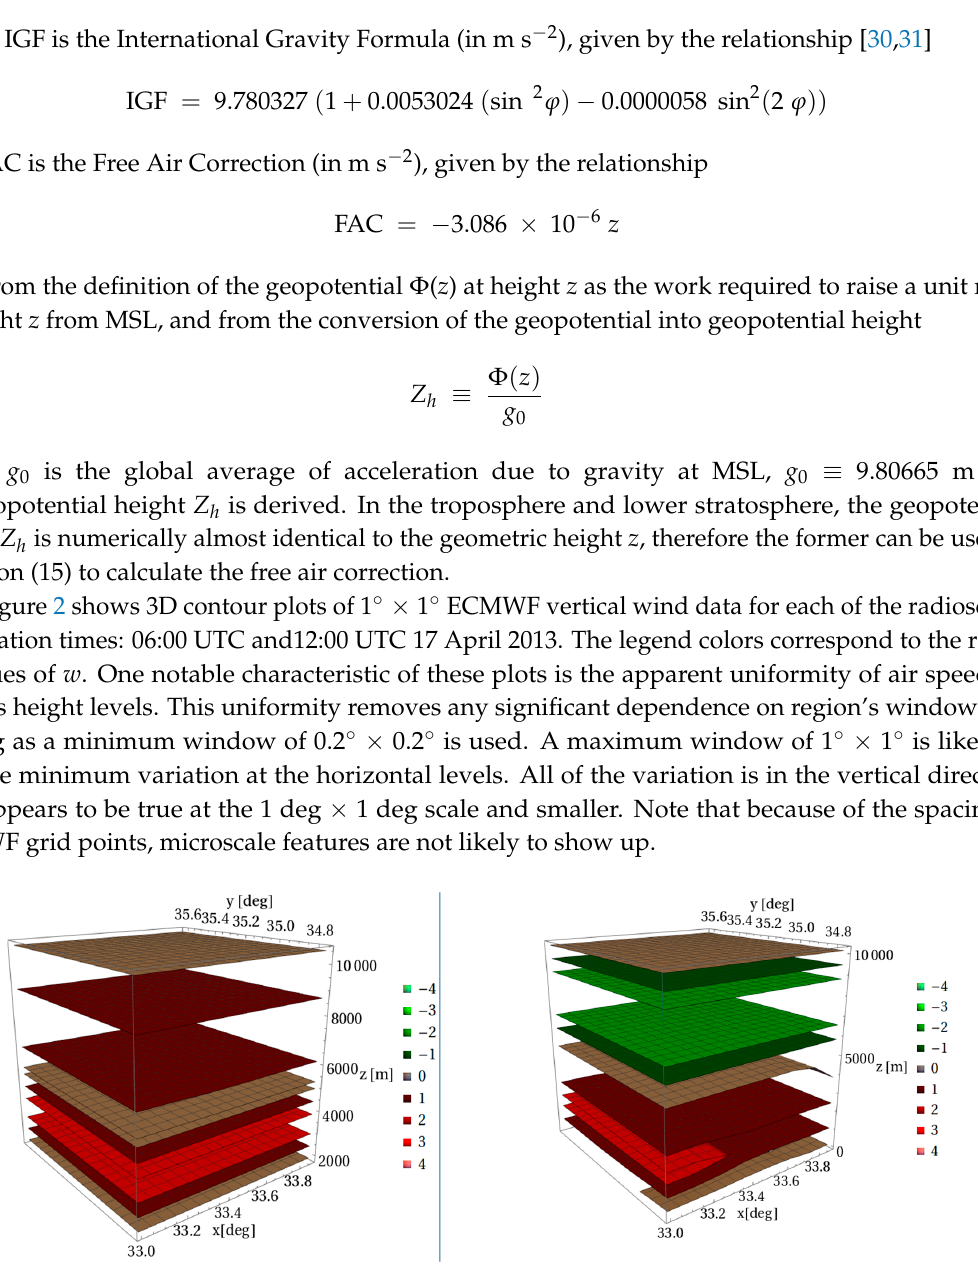
Figure 2. 1 ◦ × 1 ◦ ECMWF vertical wind data (centered over Athalassa) plotted as a 3D contour plot. Color key corresponds to w in m s − 1 . Data refer to 17 April 2013: ( left ) 06:00 UTC ( right ) 12:00 UTC ( right ).